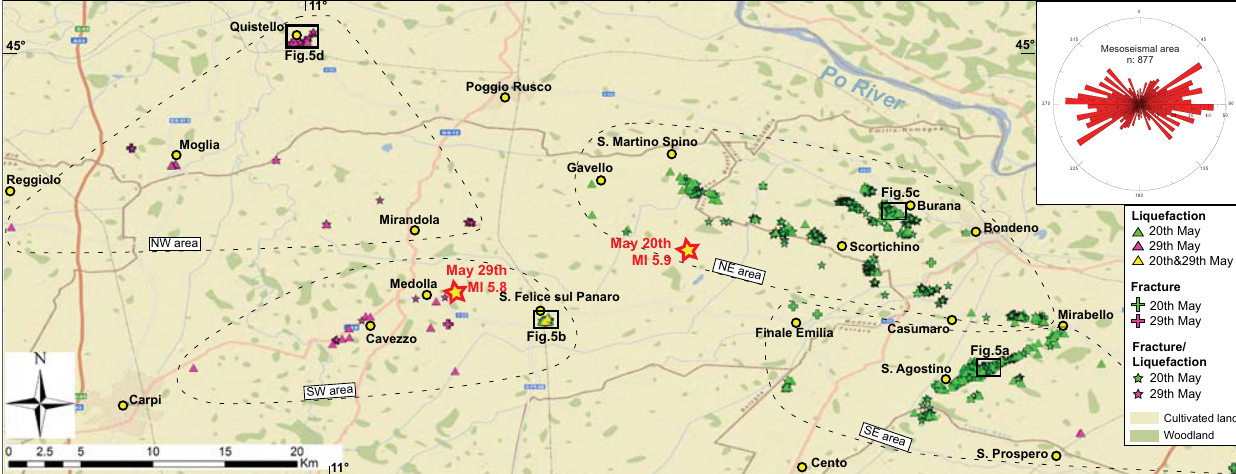
Fig. 4. Location of observed geological effects (1362 data points) distinguished according to the three main categories and the triggering seismic event. The two mainshocks and the four study areas are presented. The inset shows the rose diagram evidencing the trend distribution of the linear coseismic geological effects (877 fractures and